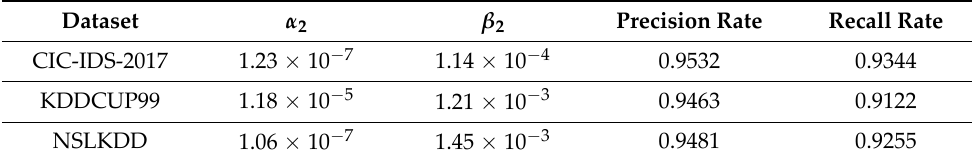
Table 5. Model hyperparameters.